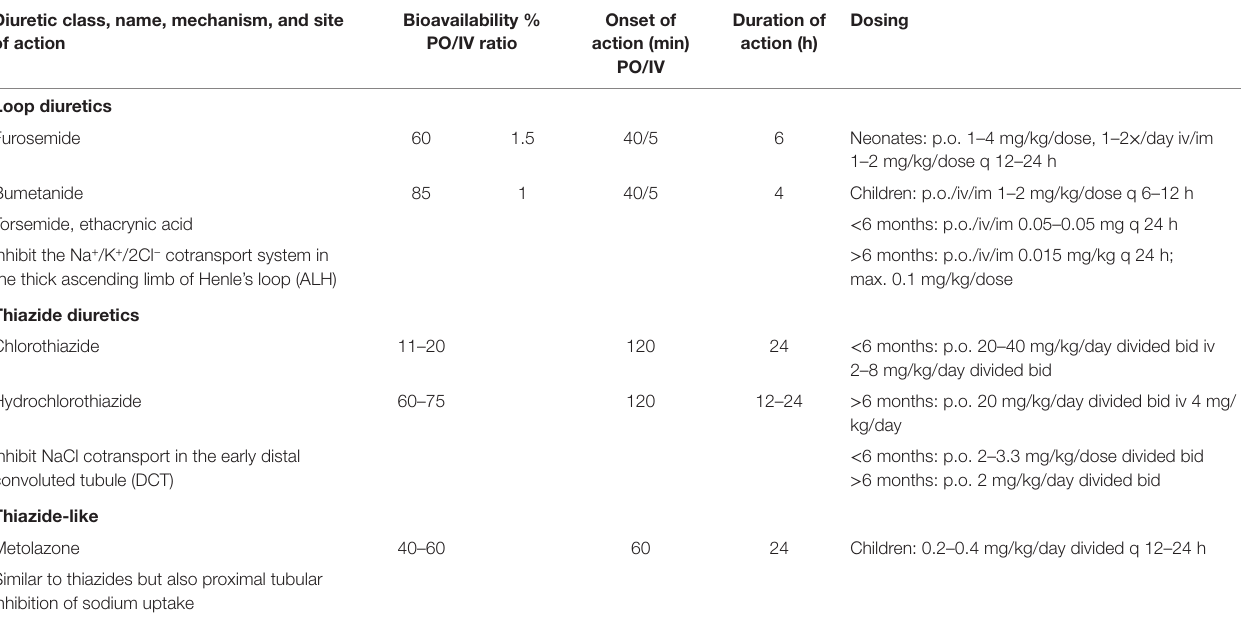
TABLe 6 | Diuretics used to manage edema in children.